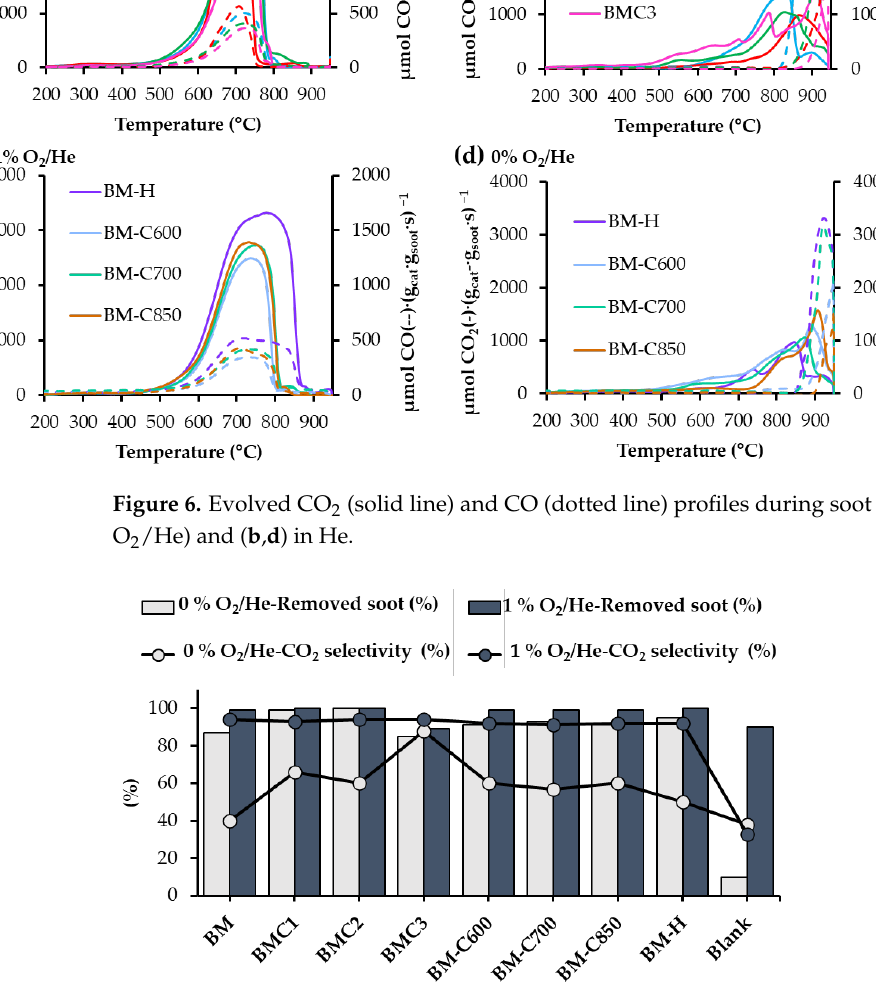
Figure 7. Percentage of removed soot and CO 2 selectivity values in He and 1% O 2 /He for BaMn 1 − x Cu x O 3 and BaMnO 3 catalyst series.